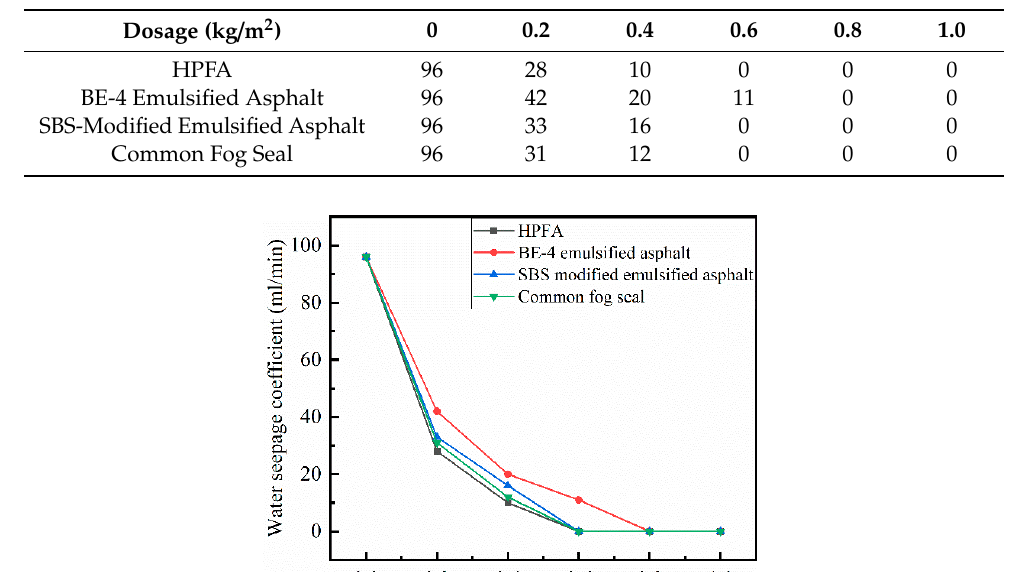
Table 9. Water seepage coefficient of fog seal with different dosage.